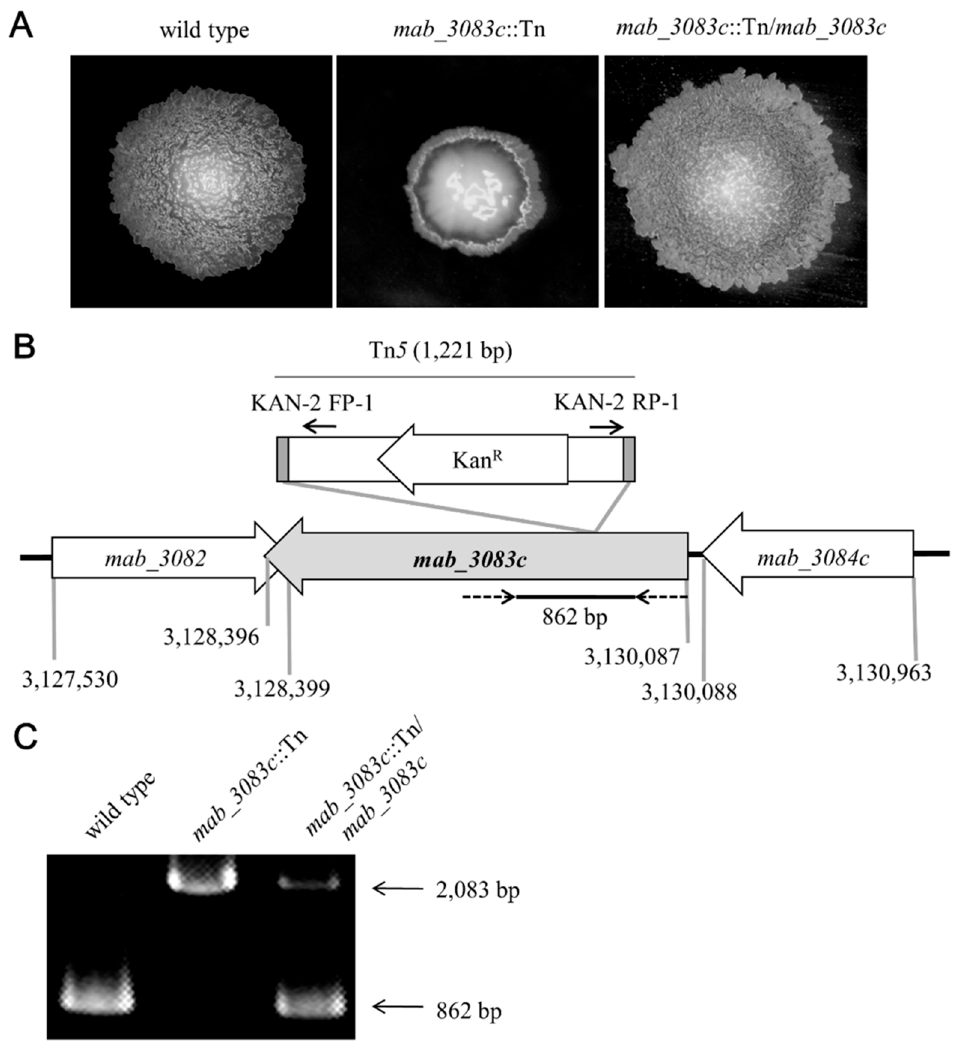
Figure 1. Characterization of mab_3083c transposon mutant. ( A ) Colony morphology of wild type, mab_3083c ::Tn, and complemented ( mab_3083c ::Tn/ mab_3083c ) strains . Cells of each of these M. abscessus variants were grown on Middle brook 7H11 agar plate supplemented with 10% OADC and incubated at 37 ◦ C for 5 days. ( B ) Diagrams of the mab_3083c locus and the inserted 1221-bp Tn 5 containing a kanamycin resistant gene (Kan R ). Gray bars represent the terminal inverted repeats of Tn 5 . Numbers on the bottom of the figure are nucleotide positions of the M. abscessus genome (GenBank accession no. NC_010397). The transposon was inserted between nucleotides 365 and 366 downstream from the initiation codon of mab_3083c . Solid arrows( → )indicate primers KAN-2 FP-1 and KAN-2 RP-1 that were used to determine the insertion site of Tn 5 . Dotted arrows(–>)denote primers used to detect insertion of Tn5 into the mab_3083c gene. ( C ) Identification of Tn5 insertion into the mab_3083c gene. The wild type strain containing the intact mab_3083c gene yielded an 862-bp PCR product, while the mab_3083c ::Tn mutant had a 2083-bp PCR product indicating insertion of Tn5 into the mab_3083c gene. The complemented strain ( mab_3083c ::Tn/ mab_3083c ) had both 862-bp and 2083-bp fragments, indicating that some copies of the mab_3083c gene from pYUB- mab_3083c were integrated into the chromosome of the strain.